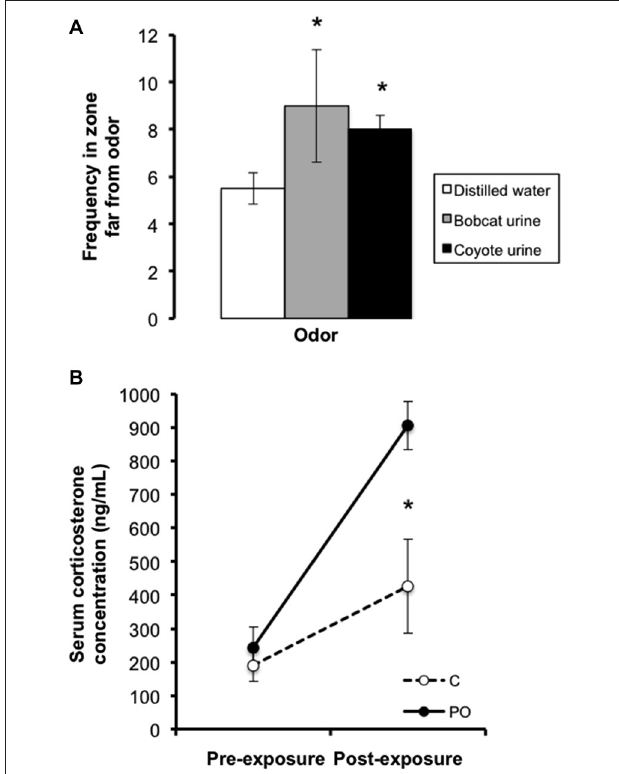
FIGURE 1 | Preliminary testing in adult females showing (A) bobcat (3 mL) and coyote (5 mL) urine elicited avoidance of the predator odor source relative to distilled water control and (B) elevated basal CORT levels after a week of unpredictable 1 h daily predator odor exposure . Data are average ± SEM. Predator Odor (PO); Control (C). * P ≤ 0.05, effect of predator odor